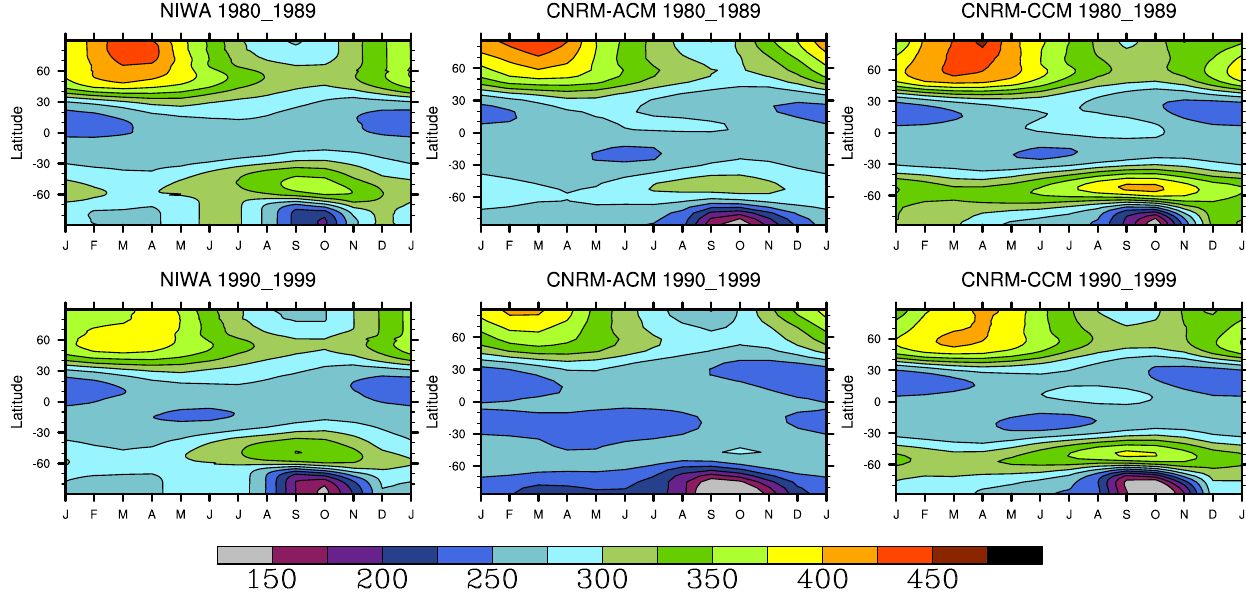
Fig. 18. Climatological monthly zonal total column ozone (DU) over two 10-yr periods, 1980–1989 (first row) and 1990–1999 (second row), for BSv2.7 observations (left column), CNRM-ACM (middle column) and CNRM-CCM (right column) simulations. up with a correct temperature field that would be beneficial to the overall representation of the